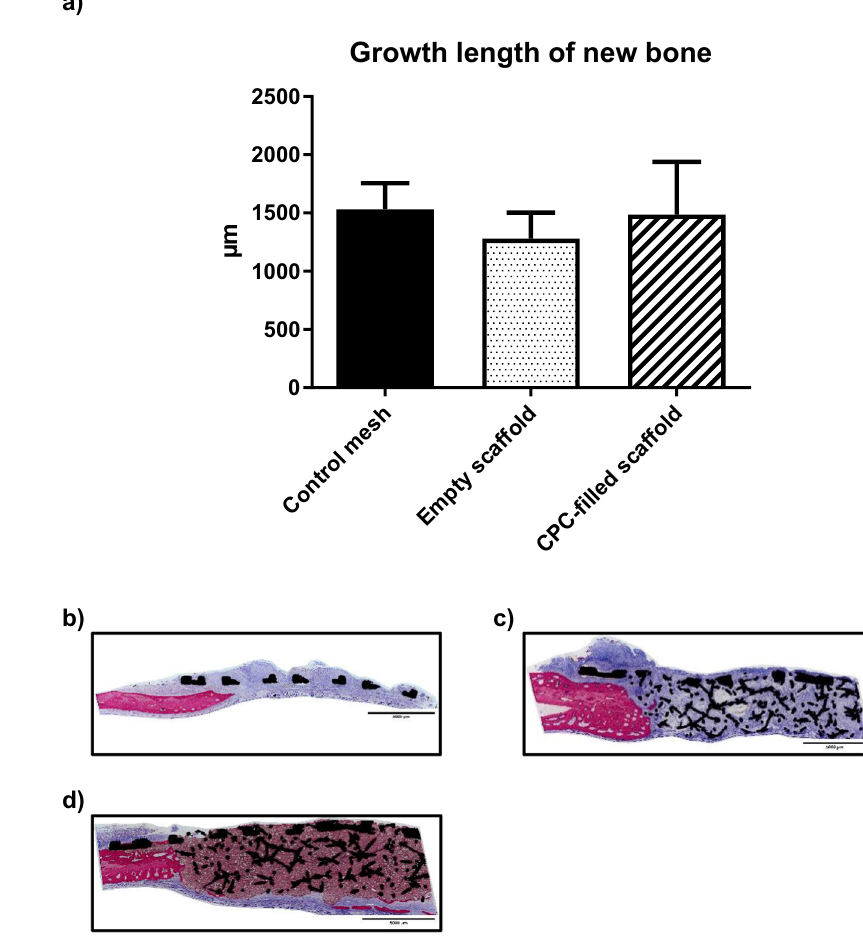
Fig. 6 Histological analysis shows no bone ingrowth into the scaffolds at all [( a ): average length of newly formed bone from the lateral side. Exemplary cross sections: ( b ) control group; ( c ) empty scaffold; ( d ) CPC- fi lled